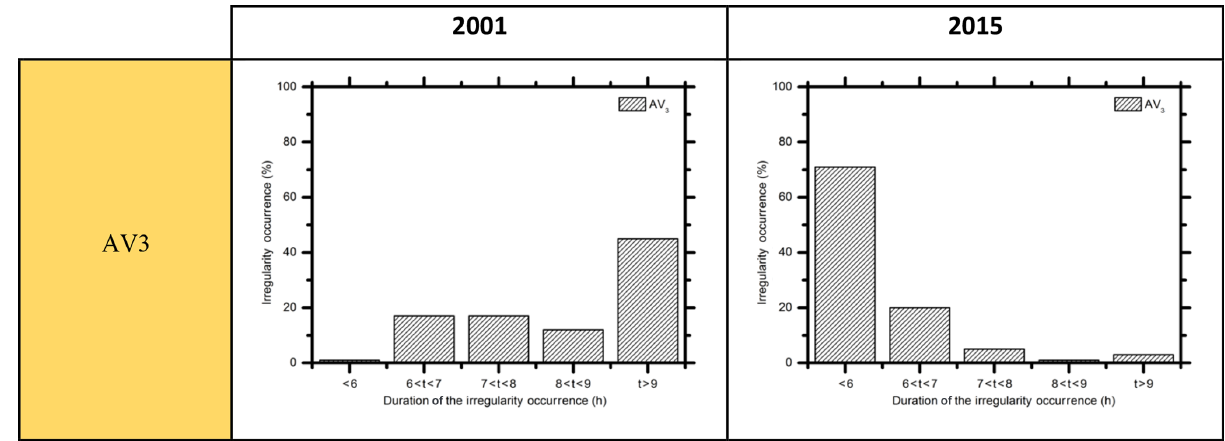
Figure 3. Occurrence of spread F in ionograms for the AV 3 index in 2001 and 2015 over São Luís to exemplify the differences between the solar flux levels.